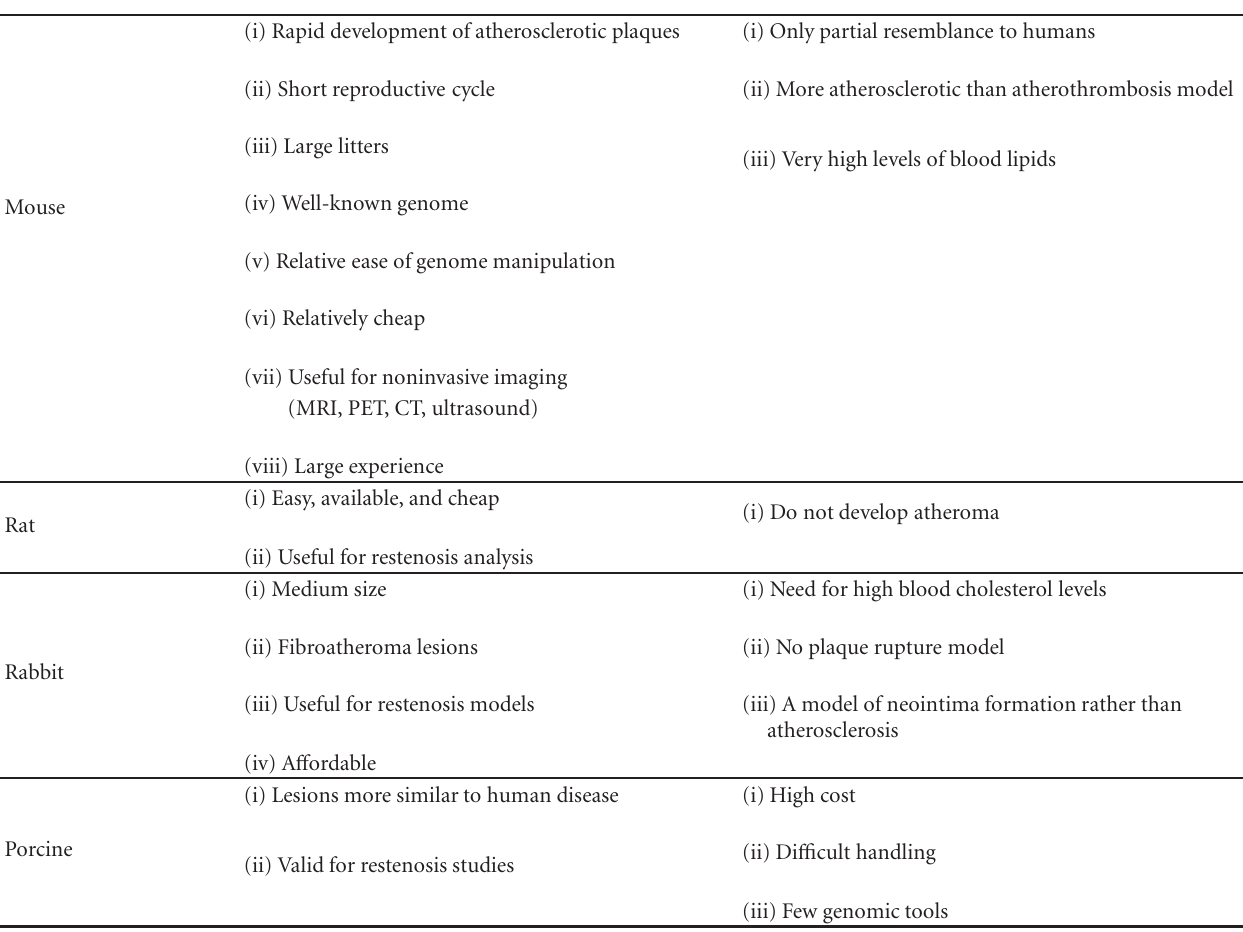
Table 1: Animal models of atherosclerosis: advantages and